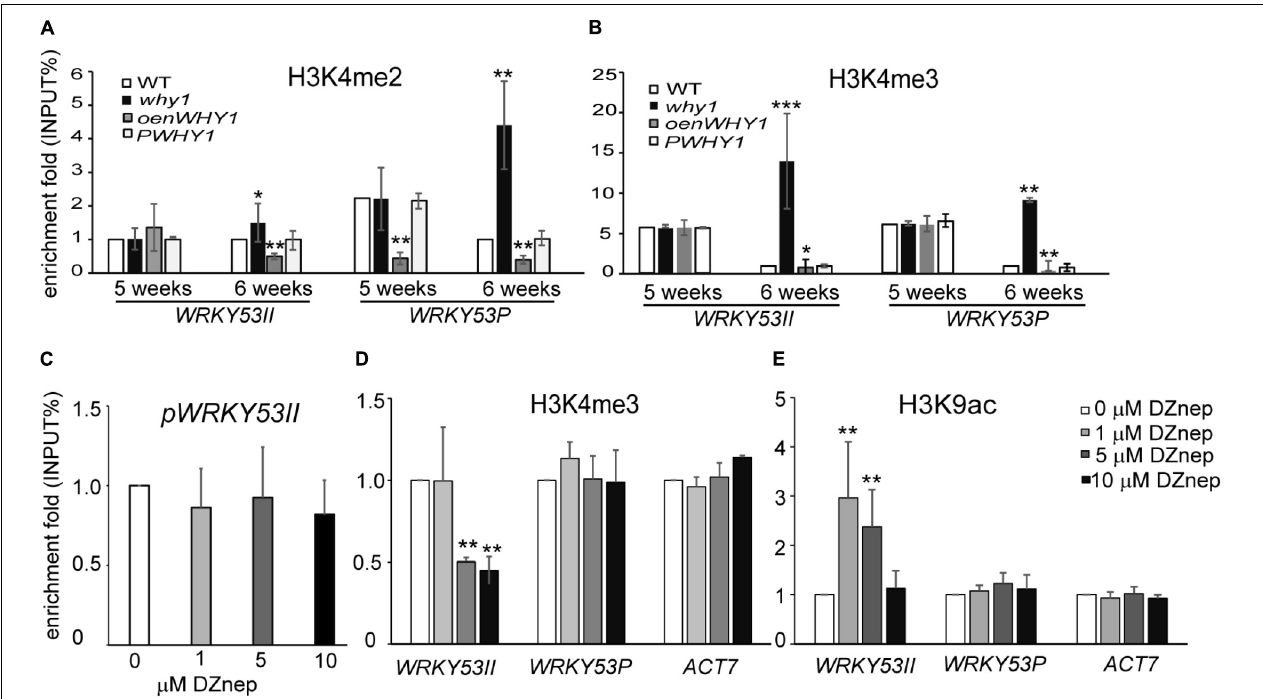
FIGURE 2 | WHIRLY1 regulates the H3K4me3 enrichment at WRKY53 at senescence initiation stage. (A,B) ChIP experiments were performed to assess H3K4me2 (A) and H3K4me3 (B) levels at WHIRLY1 binding region (WRKY53II) and translation start region (WRKY53P) of WRKY53 using rosette leaves of why1 , oenWHY1 , wild-type (WT), and PWHY1 plants. why1, whirly1 ; oenWHY1 , oenWHIRLY1 ; and PWHY1 , Pwhirly1:WHIRLY1. The relative level (input %) was normalized to that of 5-week-old WT. Three biological replicates and three technique replicates were used to analyze. Error bar shows the SD ( n = 3 × 3). Asterisk indicate significant differences ( ∗ P < 0.05, ∗∗ P < 0.01, and ∗∗∗ P < 0.001) based on Student’s t -test. (C–E) The binding affinity of WHIRLY1 at promoter of WRKY53 (pWRKY53II) (C) , H3K4me3 (D) , and H3K9ac (E) levels at WRKY53II and WRKY53P regions of WRKY53 using 6-week-old rosette leaves of PWHY1 plants after 24 h induction with 1, 5, and 10 µ M 3-Deazaneplanocin A, dimethylsulfoxide (Dznep) was used as a control in treatment. Actin7 was used as an inner control for ChIP–qPCR. ChIP–qPCR were carried out with antibody against HA, H3K4me3, and H3K9ac. Three biological replicates and three technique replicates were used to analyze. Asterisk indicate significant differences ( ∗ P < 0.05 and ∗∗ P < 0.01) based on Student’s t